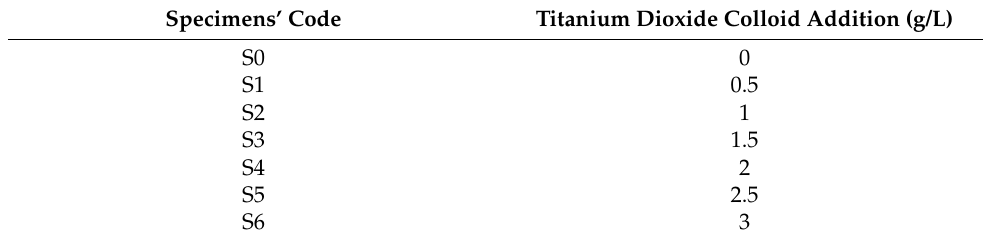
Table 1. The specimens’ code MAO parameters. Specimens’